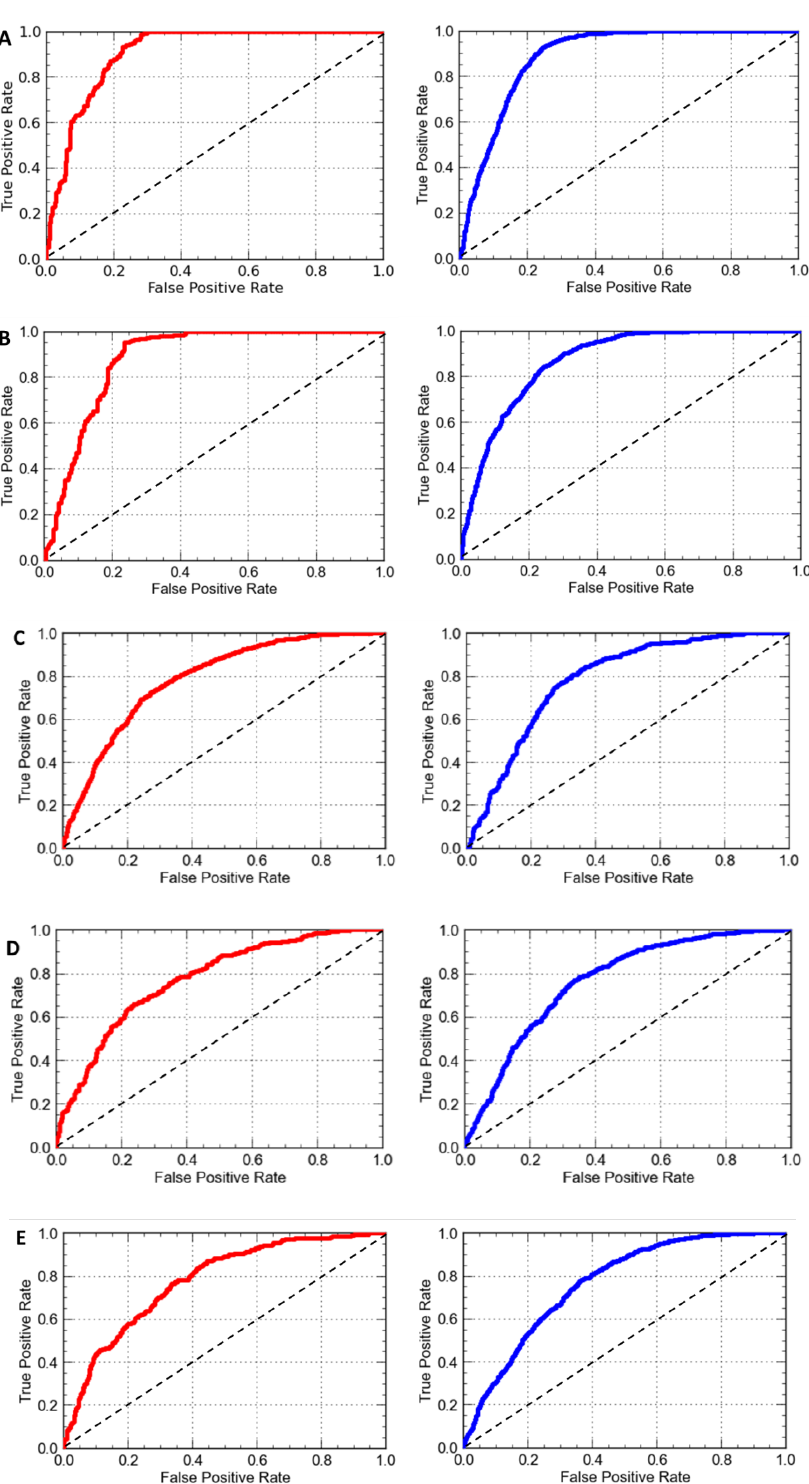
Figure 10. ROC curve of 1985 ( red ) and 2014 (blue) in ( A ) Riyadh; ( B ) Jeddah; ( C ) Makkah; ( D ) Al-Taif and ( E ) Eastern